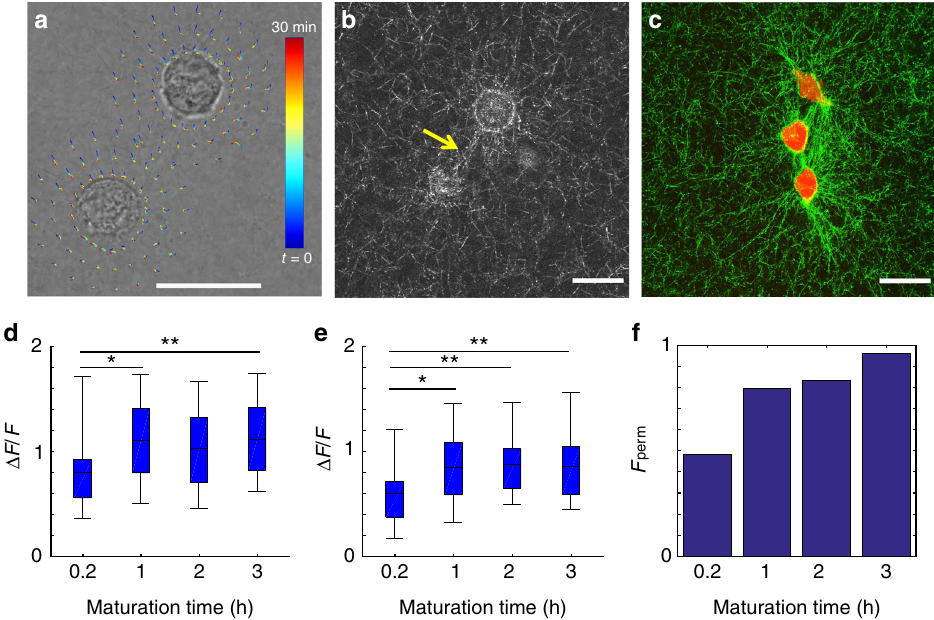
Fig. 1 Cell traction forces irreversibly induce the formation of collagen bundles. a Reconstructed streamlines showing the spatial-temporal pro fi le of the cell-induced matrix deformation. The deformation fi eld from frame to frame is calculated via re fl ectance particle image velocimetry 22 . Color code (blue to red) is linearly proportional to maturation time 0 − 30 min). b Confocal re fl ection image of the collagen matrix showing a collagen bundle (arrow) between two MDA-MB-231 cells. c Collagen bundles simultaneously form between multiple cell pairs. Red: GFP-labeled MDA-MB-231 cells. Green: re fl ectance image of collagen fi bers. d The relative re fl ectance intensity Δ F / F of collagen bundles compared to the background. e Δ F / F of collagen bundles after disrupting the cell traction forces by Cytochalasin-D treatment. In d , e , ~30 cell pairs are sampled for each maturation time. The thick black lines, box edges and whiskers represent the median, fi rst/third quartiles, and lower/upper 5% values, respectively. ANOVA and Fisher ’ s least signi fi cant difference procedure is used to evaluate the difference of Δ F / F corresponding to different maturation times. * p < 0.05, ** p < 0.01. Differences between non-labeled pairs are not signi fi cant. f Fraction of permanent collagen bundles F perm as a function of maturation time. Scale bar: 20 μ